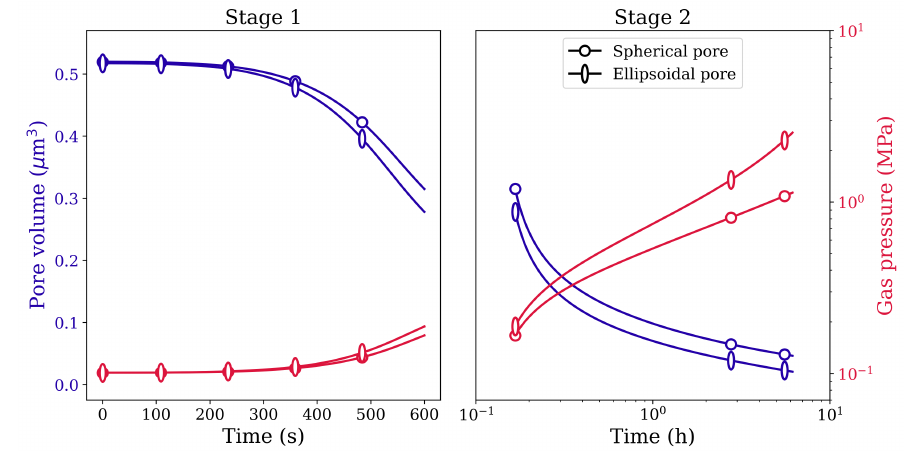
Figure 10. Void volume reduction in Stage 1 and Stage 2 HIP loading for spherical and ellipsoidal voids of identical volume under 100 MPa isostatic pressure at 1561 K.